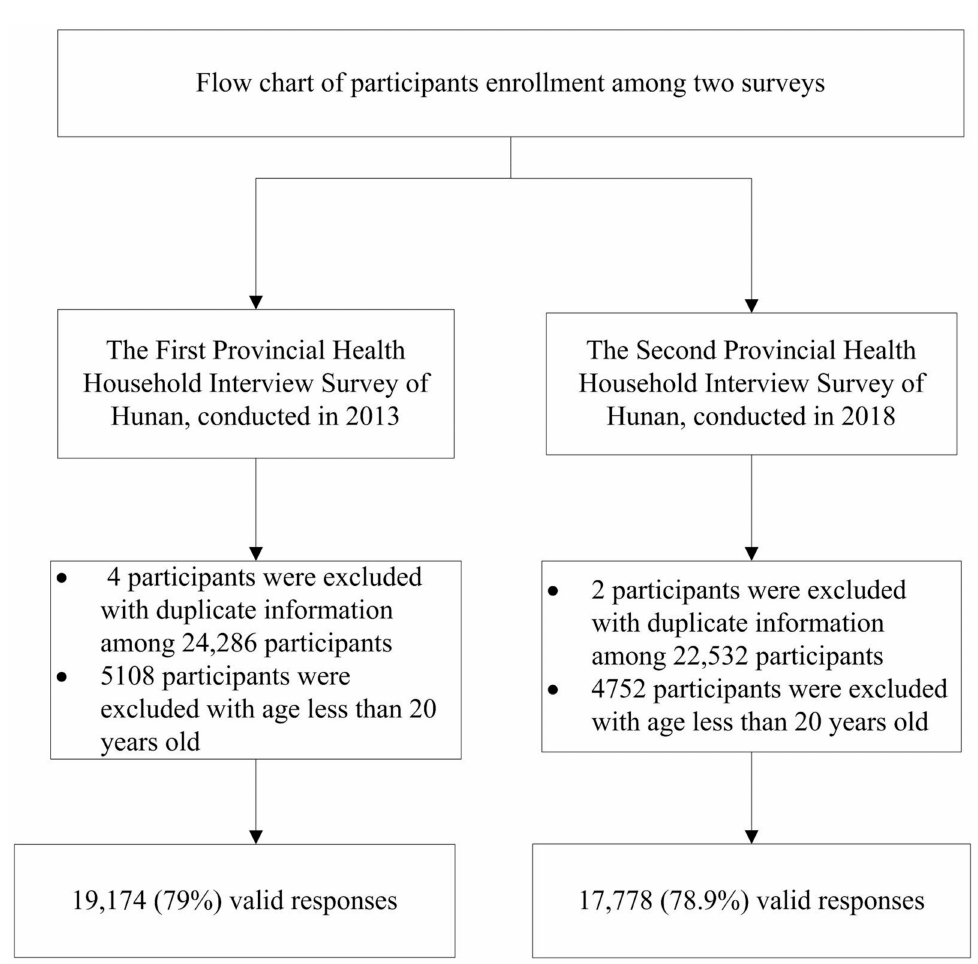
Figure 2. Sample selection procedure of health service household interview surveys of Hunan province, China, in 2013 and 2018. Table 1. Characteristics of participants in health service household interviews of 2013 and 2018 in Hunan Province, China.